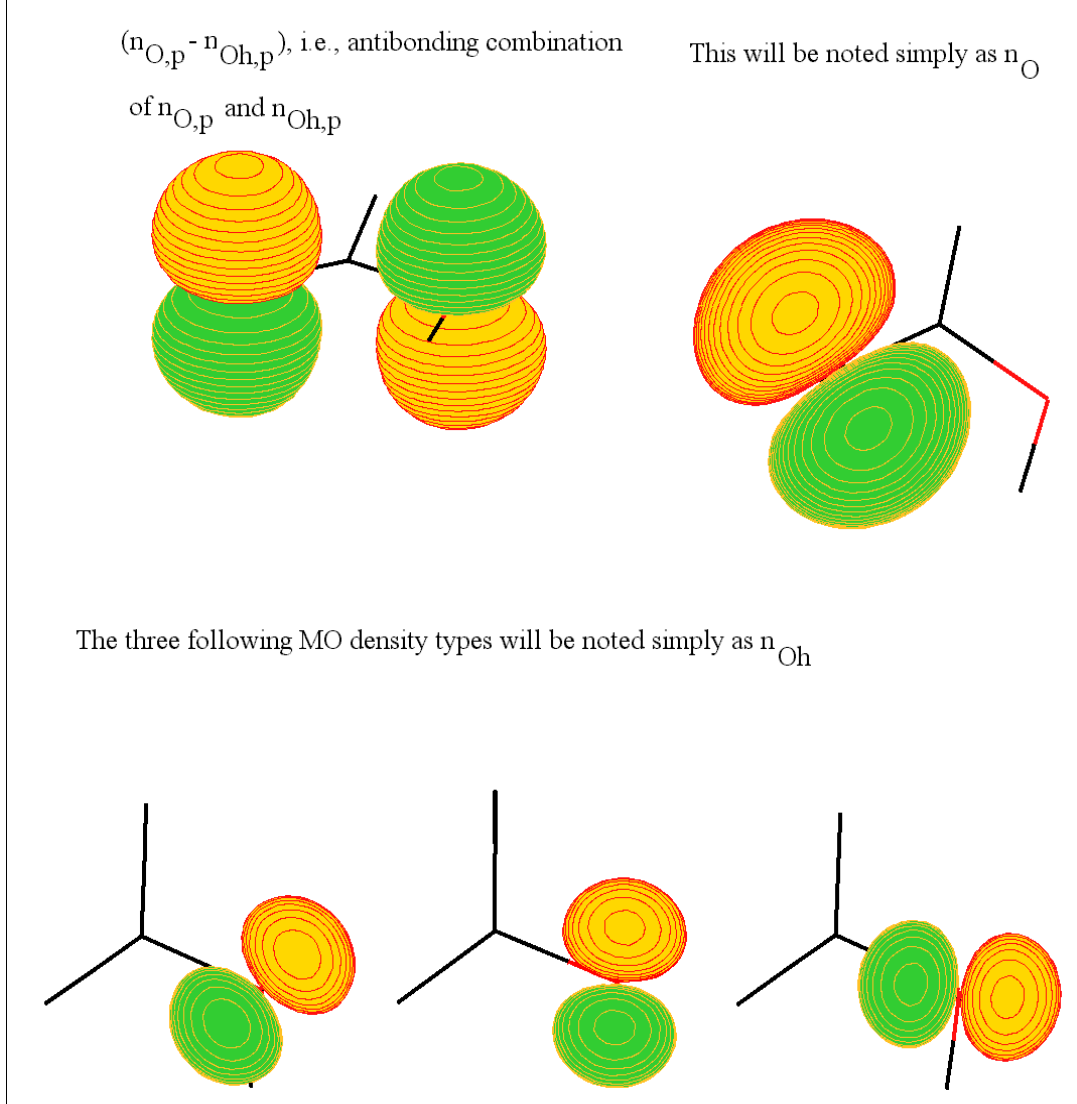
Figure 2: Labeling of the MO lone pair types on the carboxylic oxygens.